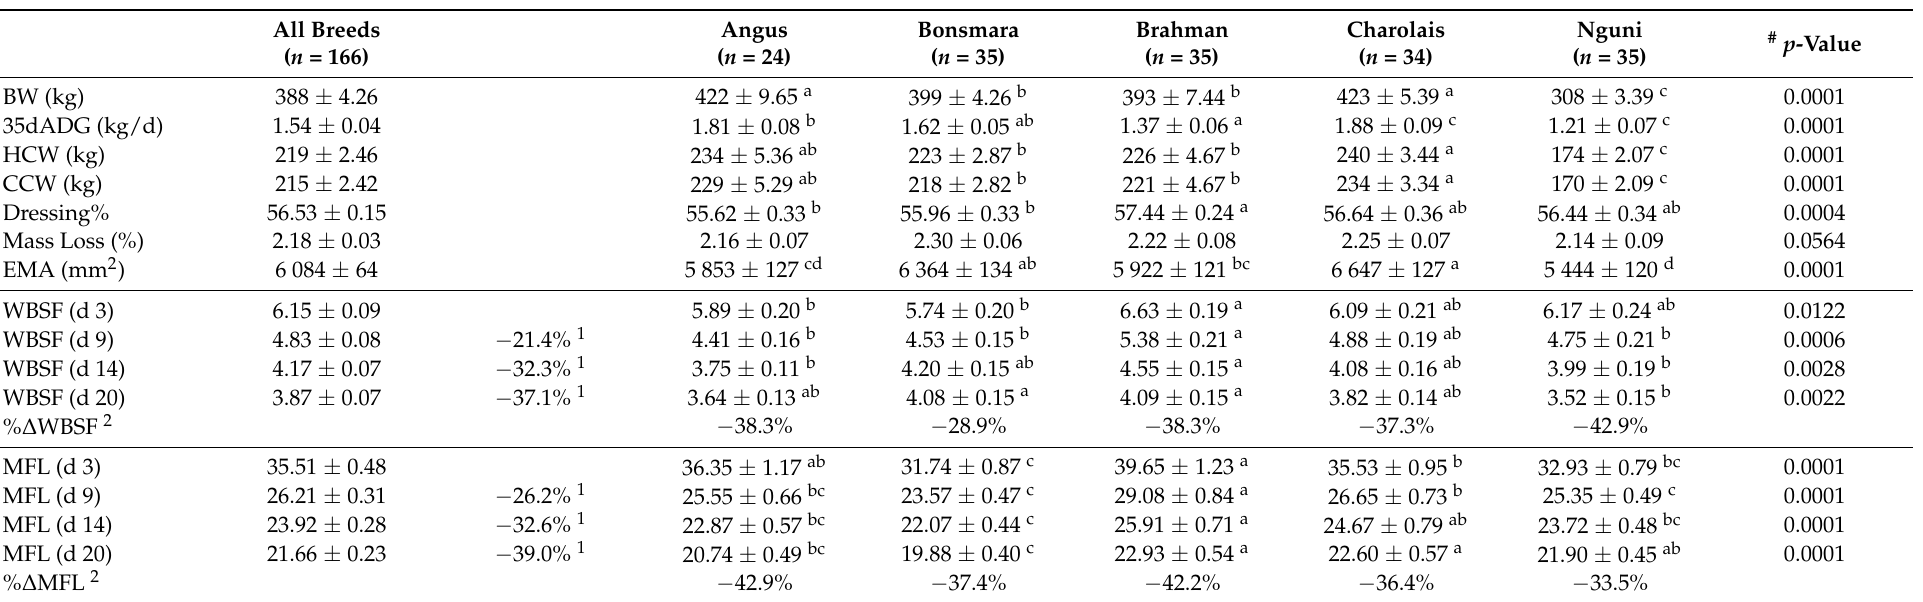
Table 1. Descriptive statistics—means of the pooled data of all breeds and least squares means within breeds of production and tenderness data of South African feedlot-finished beef